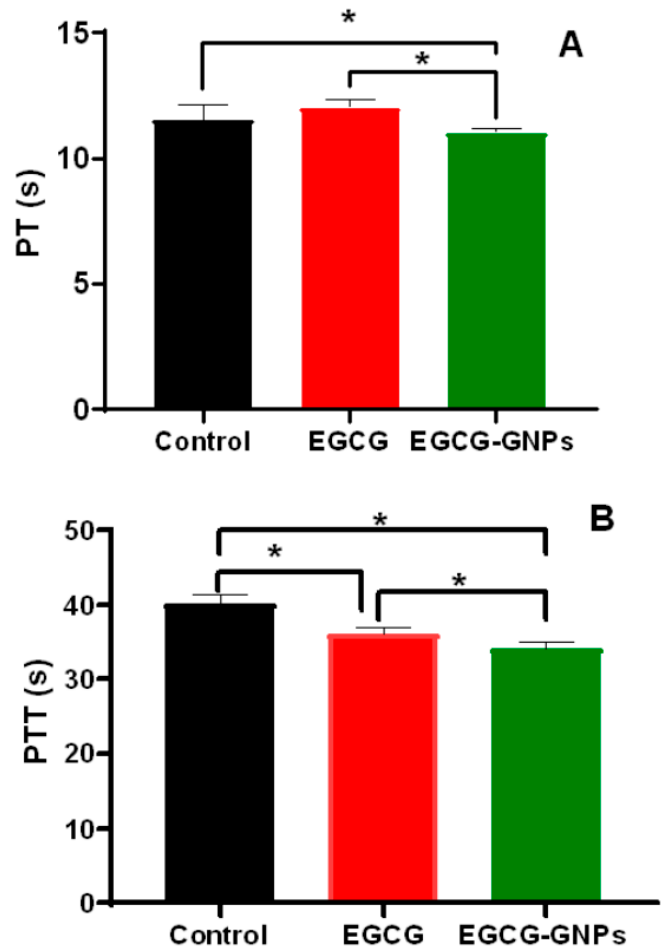
Figure 7. E ff ect of epigallocatechin-3-gallate (EGCG) and epigallocatechin-3-gallate- gold nanoparticles (EGCG-GNPs) on clotting of human blood. ( A ) Prothrombin time (PT) of human blood after incubation with EGCG and EGCG-GNPs. ( B ) Partial thromboplastin time (PTT) of human blood after incubation with EGCG and EGCG-GNPs. * Statistically significant di ff erence ( p < 0.05). PT and PTT for blood samples incubated with either EGCG or EGCG-GNPs were within the normal range (PT ≤ 13.5 s and PTT ≤ 40 s), which further confirms their hemocompatibility.